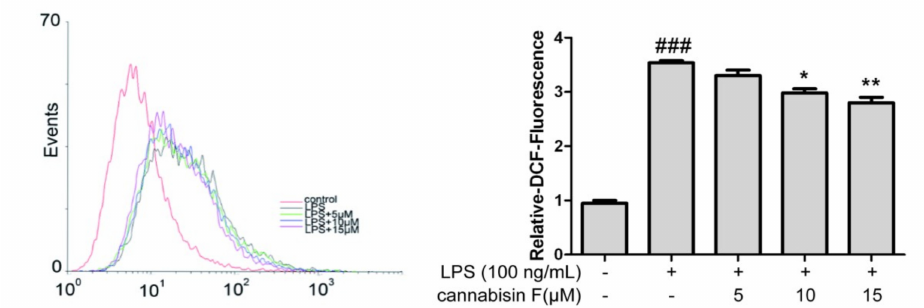
Figure 4. Cannabisin F inhibited the production of ROS in LPS-stimulated BV2 microglia cells. BV2 microglia cells were pretreated with cannabisin F (5, 10 and 15 µ M) for 1 h prior to stimulation with LPS at 100 ng/mL and incubated for 24 h. The cells were stained with DCFH-DA for 30 min and harvested. The results are presented as mean ± SD from at least three independent experiments. * p < 0.05, ** p < 0.01 as compared to the cells treated with LPS; ### p < 0.001 as compared to the